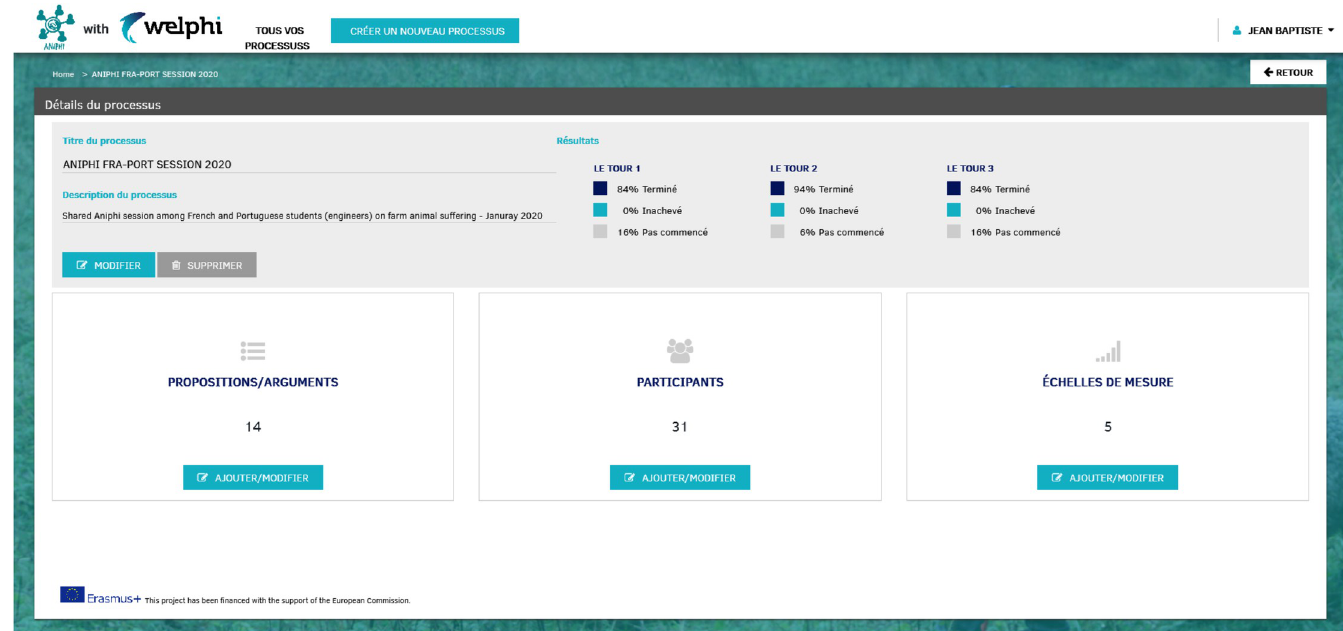
Fig 2. Process details management (user: Educator).